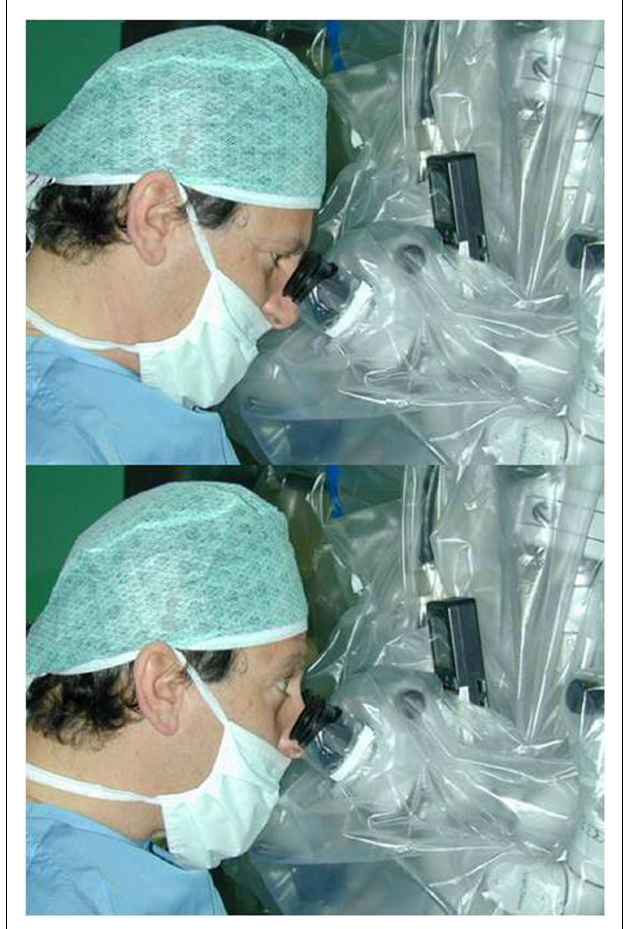
FIGURE 2 |The 7-inch high resolution LCD screen placed above the binocular head of the microscope to obtain a simultaneous vision of the endoscopic and microsurgical images by a simple gaze movement .